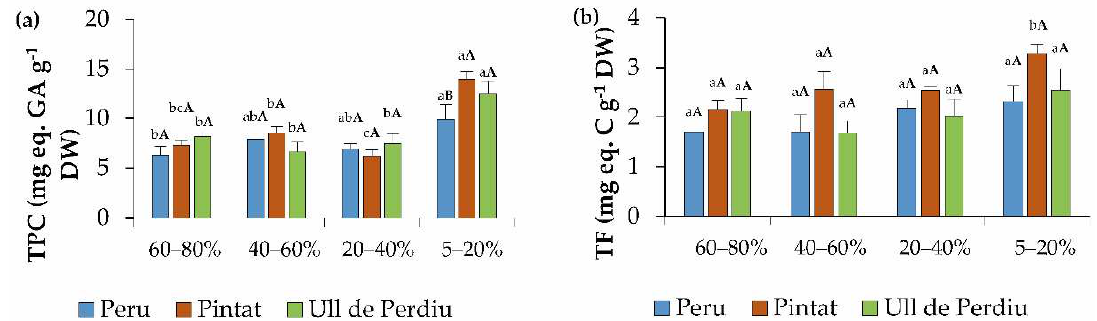
Figure 7. Leaf contents of total phenolic compounds (TPC) ( a ) and total flavonoids (TF) ( b ) in the three Phaseolus lunatus cultivars. Lowercase letters indicate significant differences within each cultivar and uppercase letters (in bold) between cultivars, but within treatments, according to Tukey’s test ( α = 0.05). p values according to one-way ANOVA.